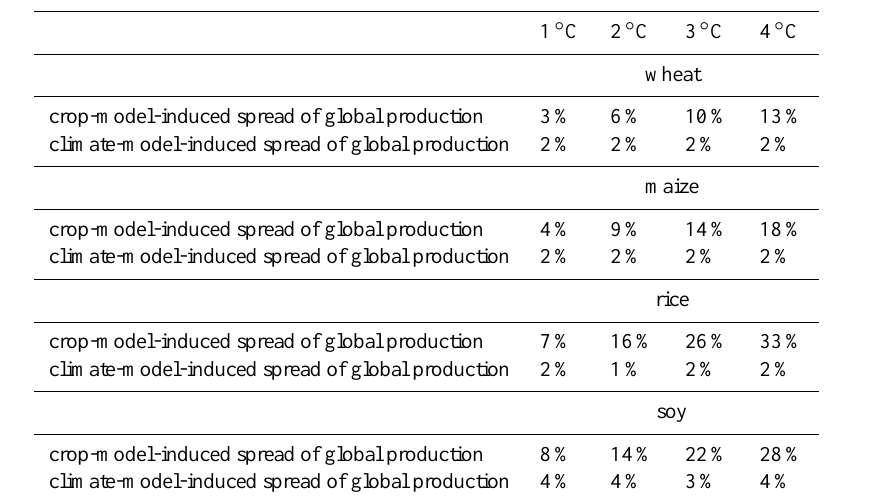
Table 4. Comparison of the crop-model-induced spread in global crop production to the climate-model-induced spread at different levels of global warming in comparison to the 1980–2010 reference level. Global production is calculated based on present-day LU and irrigation patterns not accounting for constraints on water availability (MIRCA2000; Portmann et al., 2010).